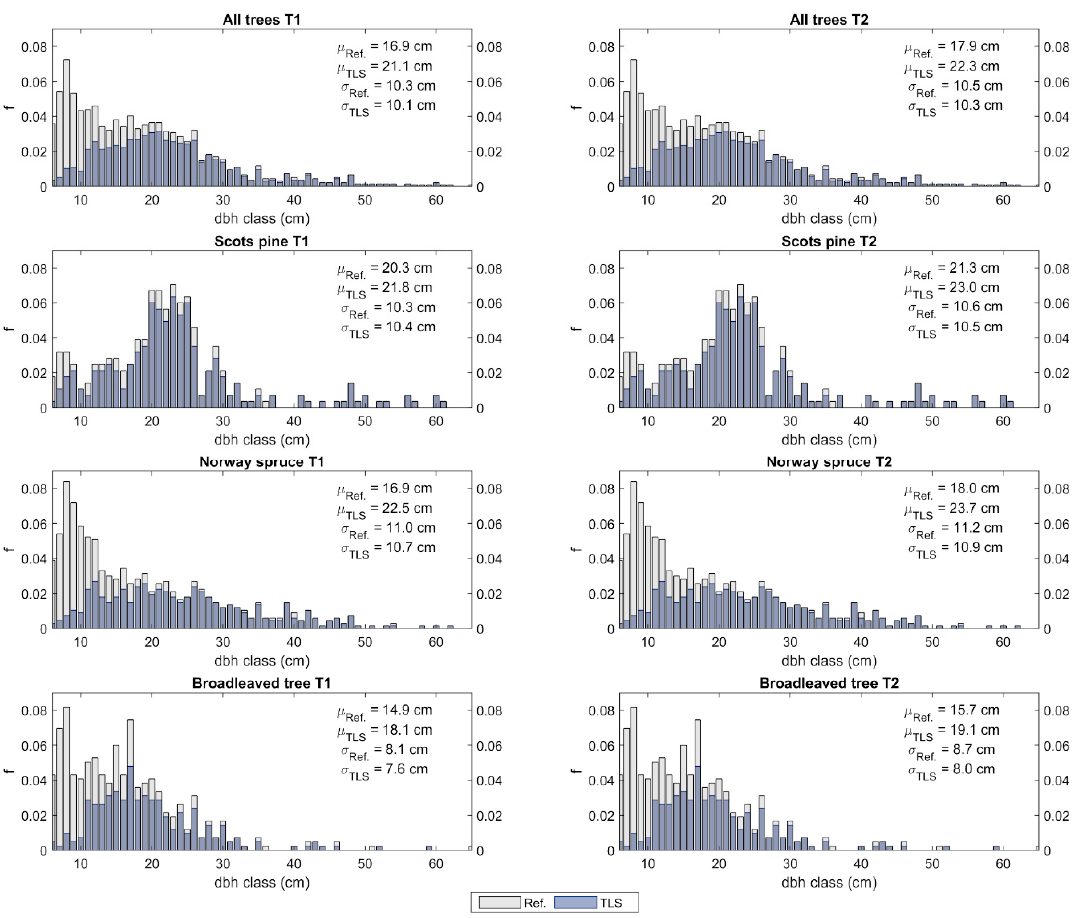
Figure 2. Diameter at breast height (dbh) distributions presenting the relative frequency (f) of trees in 1 cm dbh classes by tree species. Mean values ( µ ) and standard deviations ( σ ) based on field (Ref) and terrestrial laser scanning (TLS) measurements are presented as well. The colored bars represent the proportion of trees by dbh classes that were detected from the TLS point clouds at both time points 2014 (T1) and 2019 (T2).